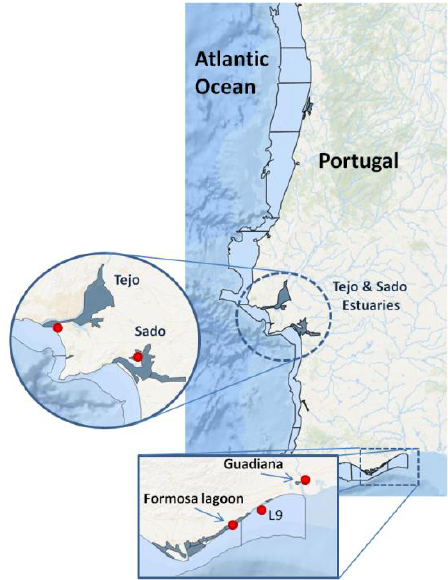
Figure 1. Location of bivalve mollusks sampling sites in the South and Southwest coast of Portugal.